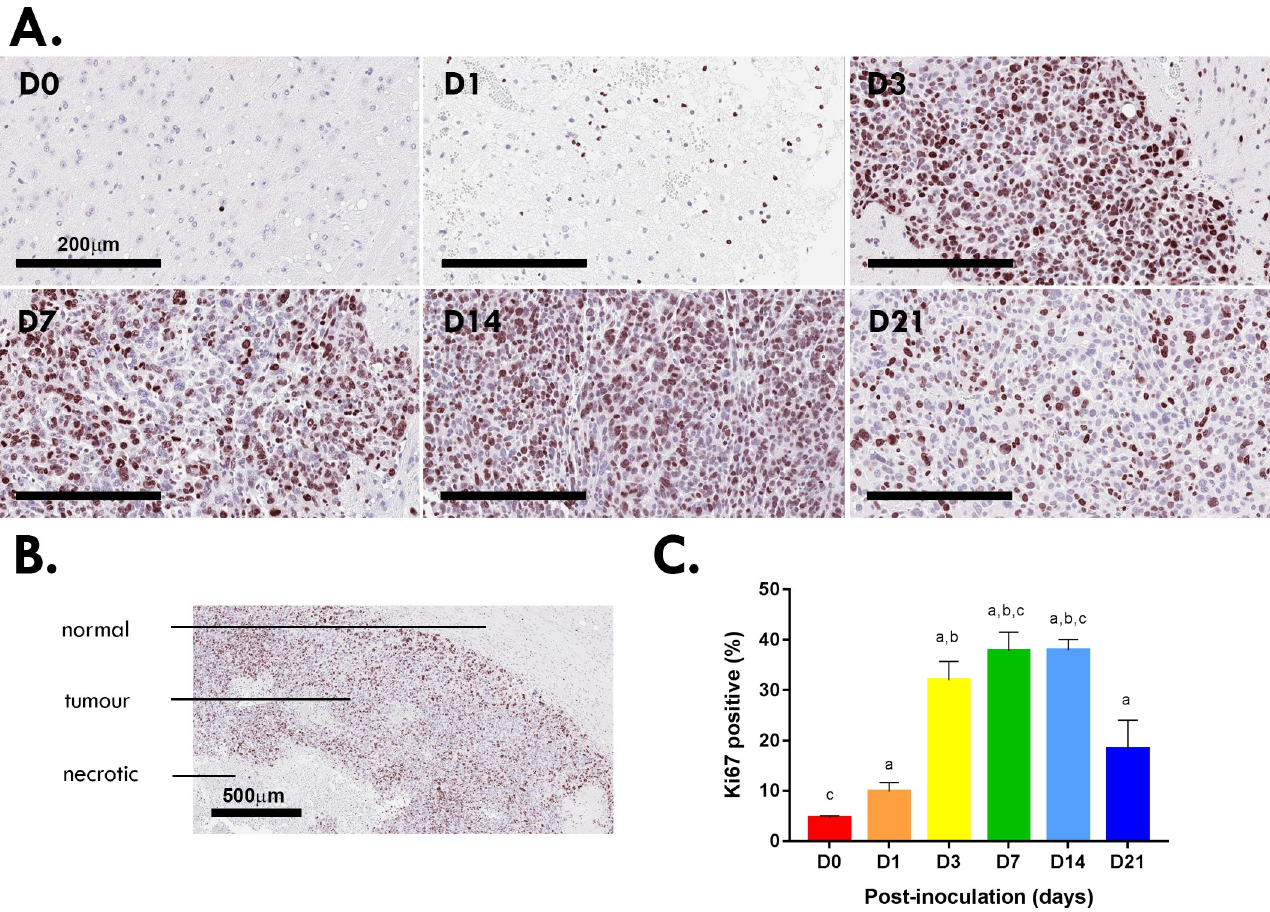
Fig 3. Ki67 proliferation index of Gl261 gliomas. Ki67 + staining at the inoculation site of murine Gl261 gliomas (A). Scale bar, 200 μ m. Tumors at day 21 post- inoculation showed signs of hypoxia/necrosis (B). Scale bar, 500 μ m. Quantitation of five HPF for each murine brain (N = 12 per time point; C). Data are expressed as mean ± SEM per HPF. a p < 0.05 vs D0, b p < 0.05 vs D1, c p < 0.05 vs D21 by Tukey’s multiple comparison test.